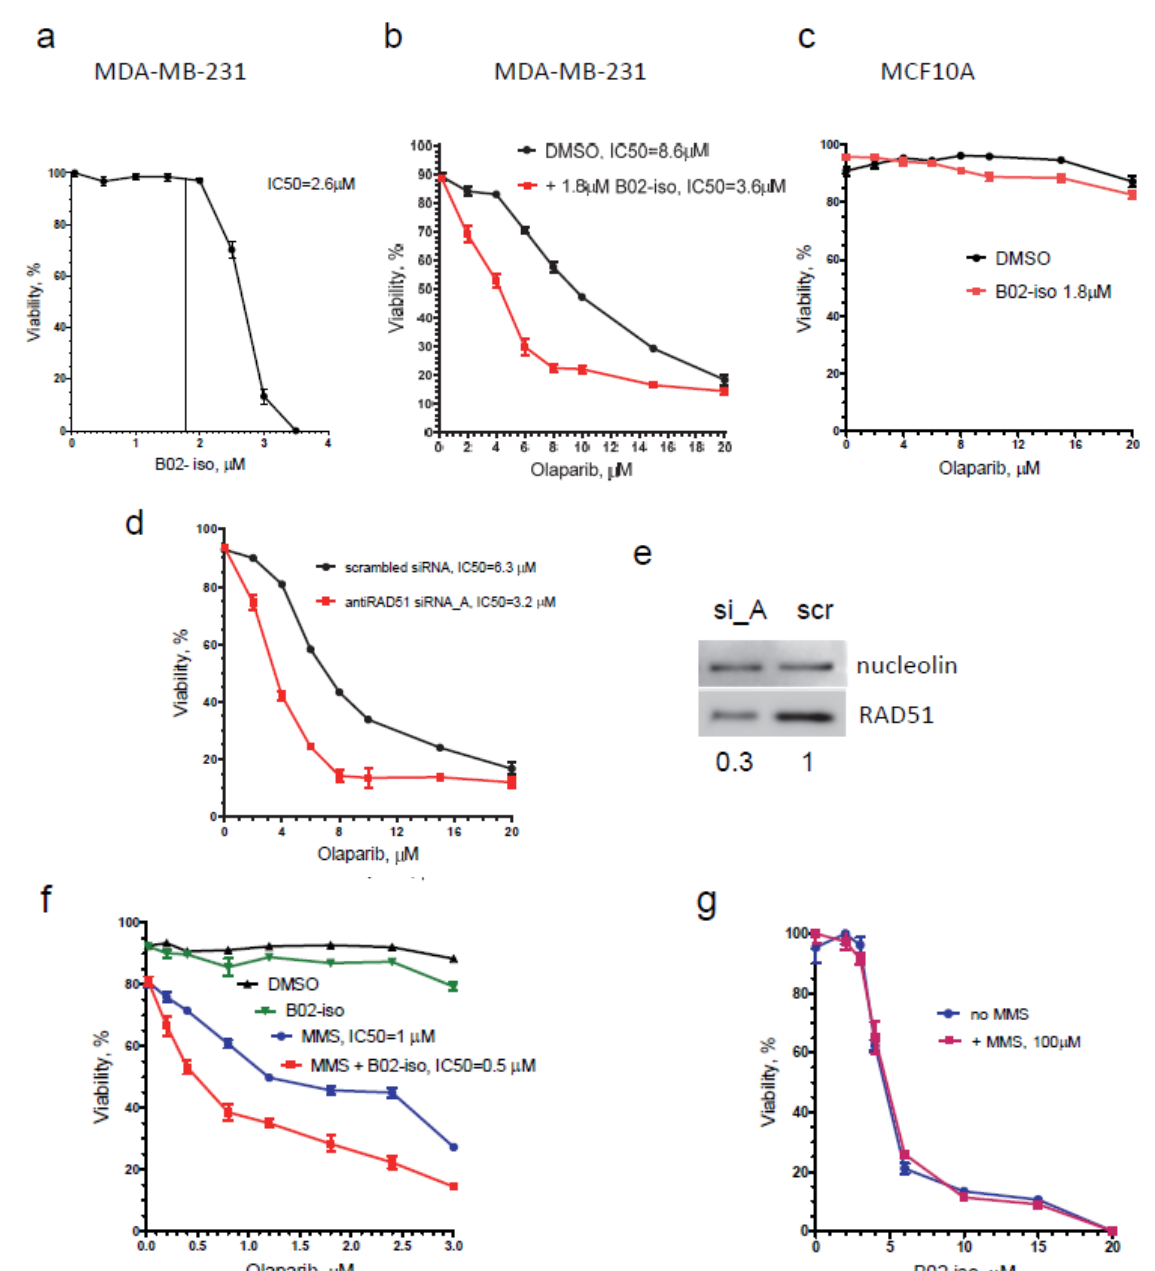
Figure 7. B02-iso potentiates the effect of olaparib on MDA-MB-231 cells. ( a ) Viability of MDA-MB-231 cells treated with B02-iso for 10 days; ( b ) B02-iso (1.8 µM) sensitizes MDA-MB-231 cells to olaparib upon 10 days of treatment; ( c ) B02-iso (1.8 µM) does not sensitize MCF10A cells to olaparib upon 10 days of treatment; ( d ) RAD51 knockdown sensitizes MDA-MB-231 cells to olaparib. MDA-MB-231 cells were transfected with either scrambled siRNA or anti-RAD51 siRNA_A and treated with olaparib for 10 days after transfection; ( e ) Levels of RAD51 72 h after transfection with scrambled (scr) or anti-RAD51 siRNA_A (si_A, Origene); ( f ) 1 h MMS treatment sensitizes MDA-MB-231 cells to olaparib alone or in combination with B02-iso (2 µM) during a 4-day treatment; ( g ) 1 h MMS treatment does not sensitize MDA-MB-231 cells to B02-iso during a 4-day treatment. Experiments were repeated at least 3 times, and representative graphs are shown. Error bars indicate the SEM.